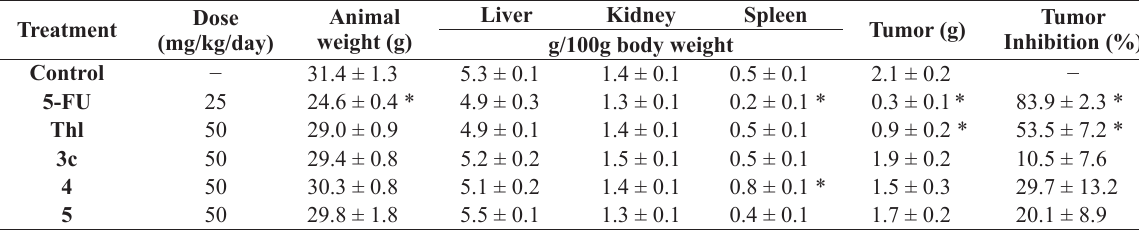
Effects of Thalidomide and N -phthaloyl amino acid derivatives on mice transplanted with Sarcoma 180 cells after 7 days of treatment by intraperitoneal route.